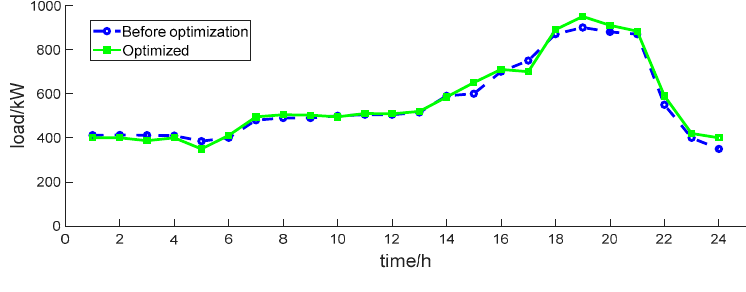
Figure 12. Overall load curve for each period.